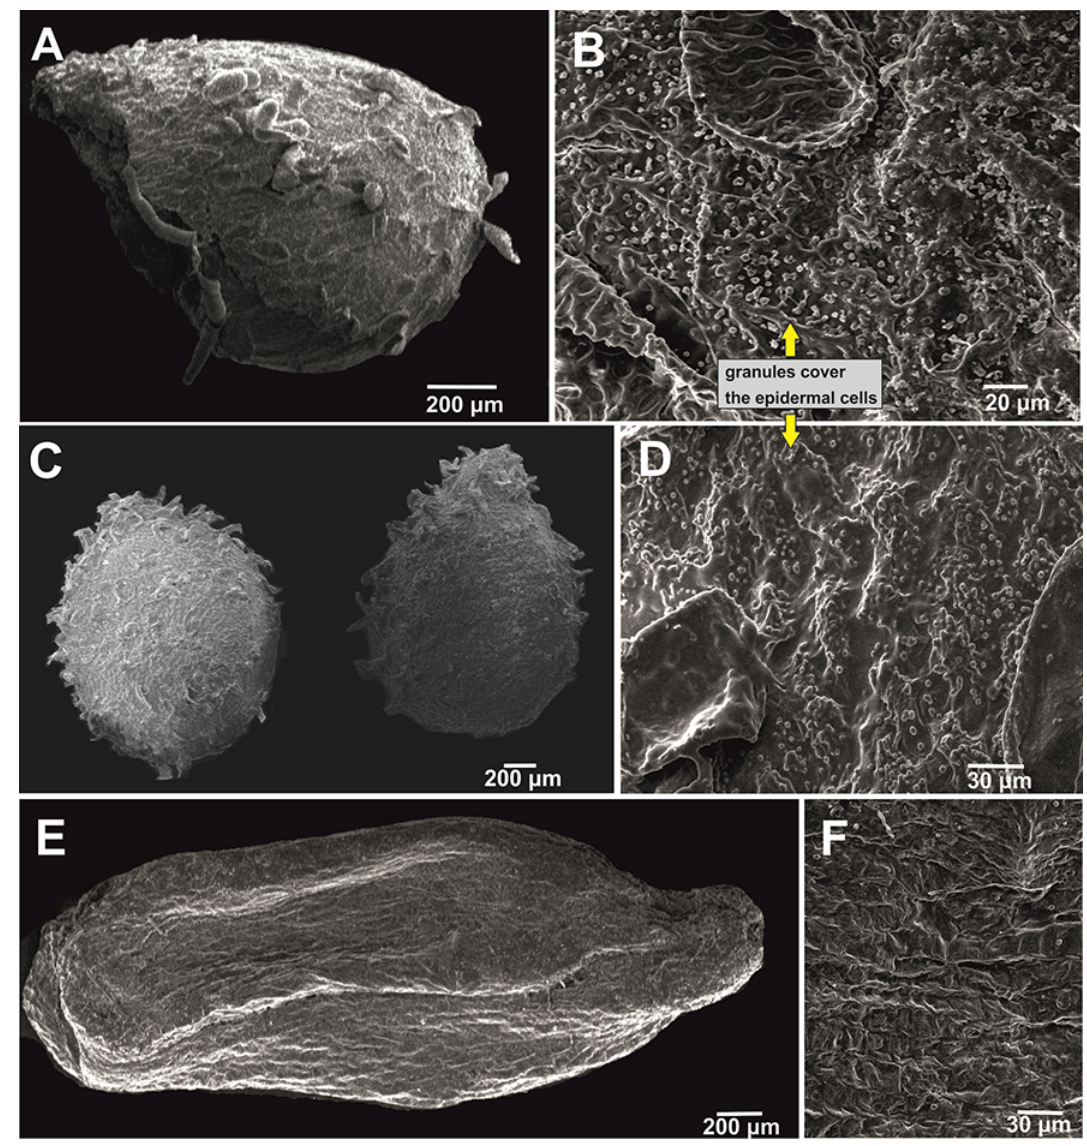
Figure 3 Seed general view and coat micromorphology of analyzed balsams from Northeast India. ( A–D ) Protrusive type: Impatiens anjawensis ( A,B ), I. spirifera ( C,D ); ( E,F ) reticulate type: I. sulcata